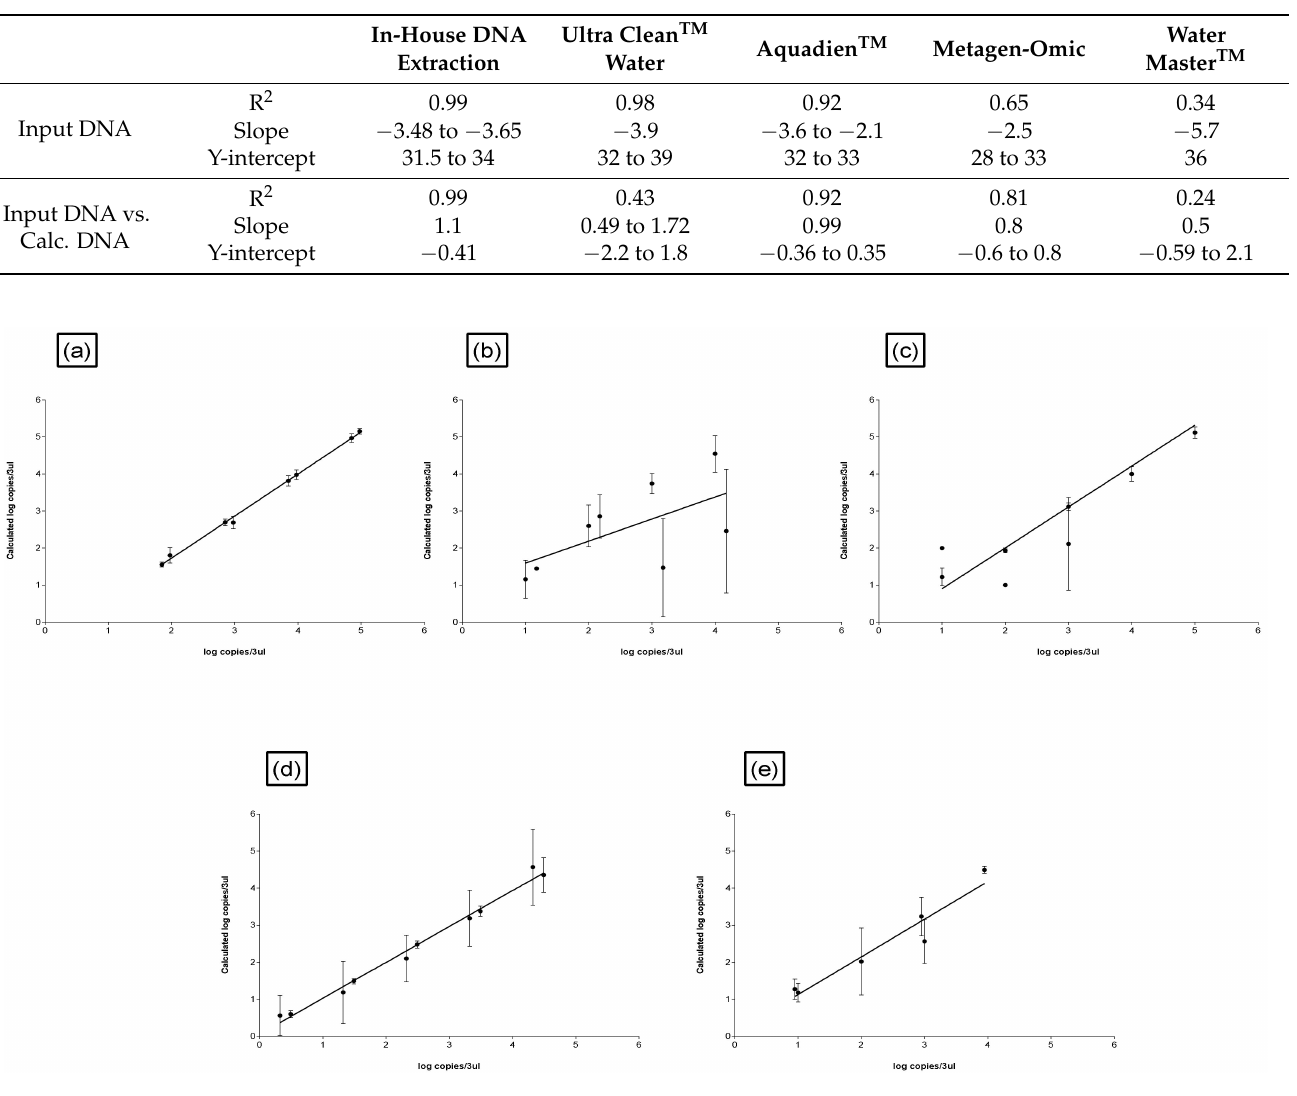
Figure 3. Input DNA versus calculated DNA from the Corbett Research Thermal Cycler software for ( a ) in-house DNA extraction method, ( b ) Water Master TM DNA purification kit (Separations, Johannesburg, South Africa), ( c ) Ultra Clean TM water DNA isolation kit (Optima Scientific PTY (LTD), Cape Town, South Africa), ( d ) Aquadien TM kit (Bio-Rad, Johannesburg, South Africa), ( e )